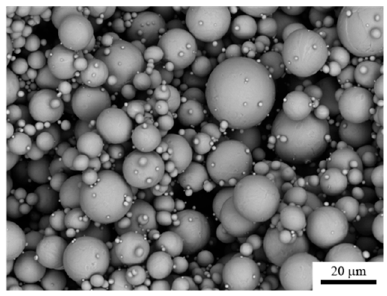
Figure 3. Scanning electron micrograph of Ti particles of this study.